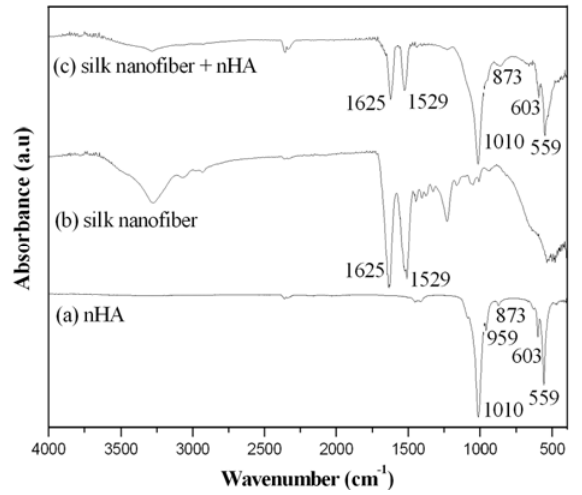
Figure 10. FT-IR spectra of ( a ) pure HA (control); ( b ) pure silk nanofibers; and ( c ) mineralized silk/nHA nanofibers.